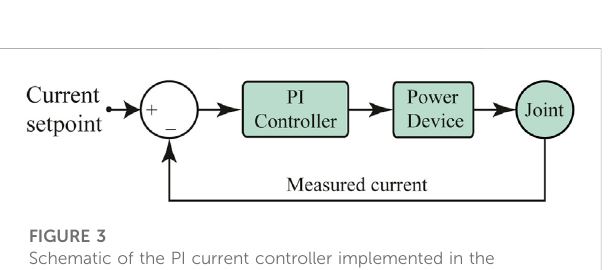
FIGURE 3 Schematic of the PI current controller implemented in the AGoRA exoskeleton as a low-level